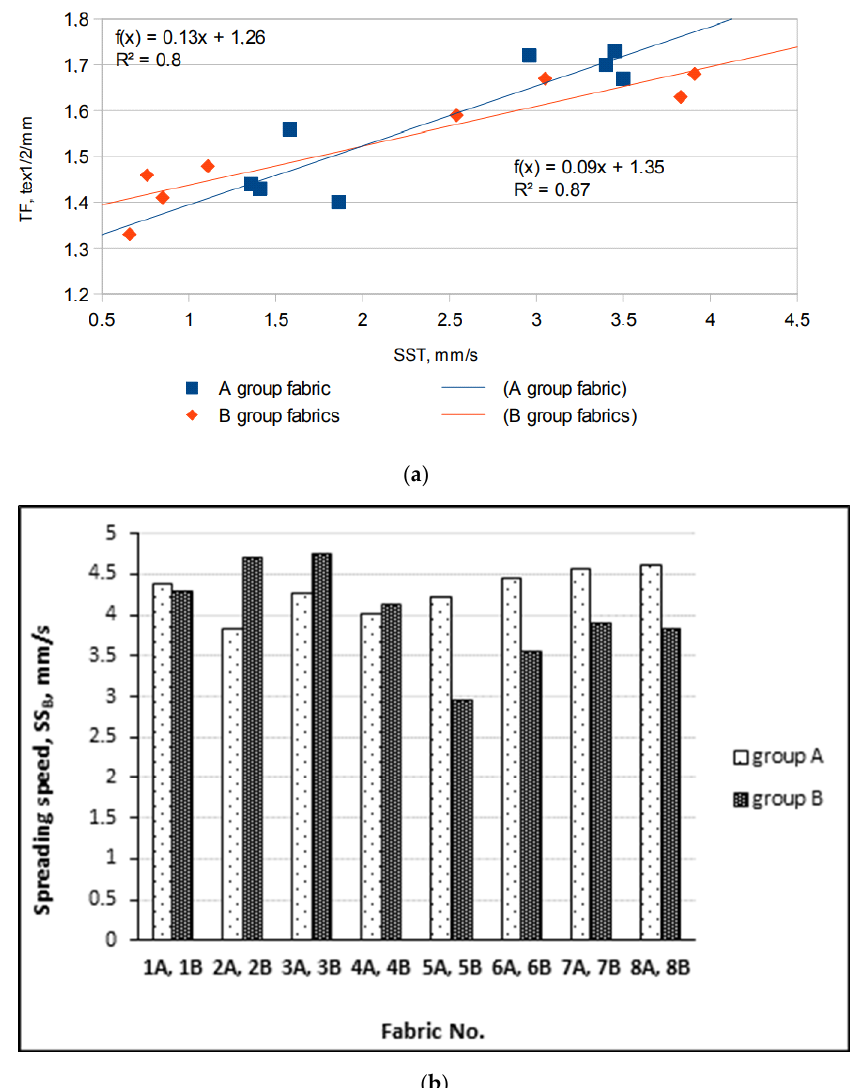
Figure 7. Graphical view of: ( a ) relationship between the spread speed of the top (inner) surface and the tightness factor; ( b ) spreading speed on outer surface of fabrics.